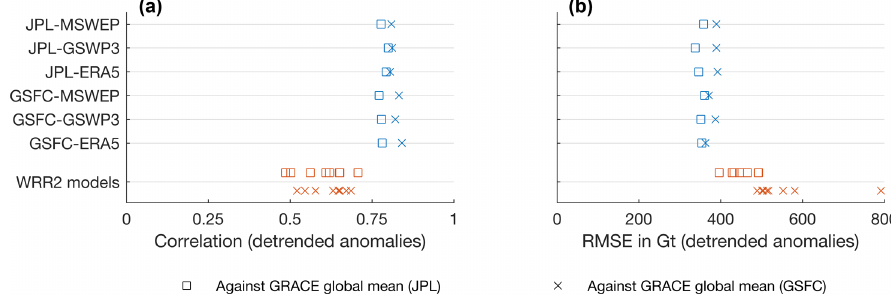
Figure 9. Agreement of the global average of different TWS model estimates (from GRACE-REC, blue, and WRR2 models, orange) with the observed TWS anomalies from JPL (squares) and GSFC (crosses) solutions.